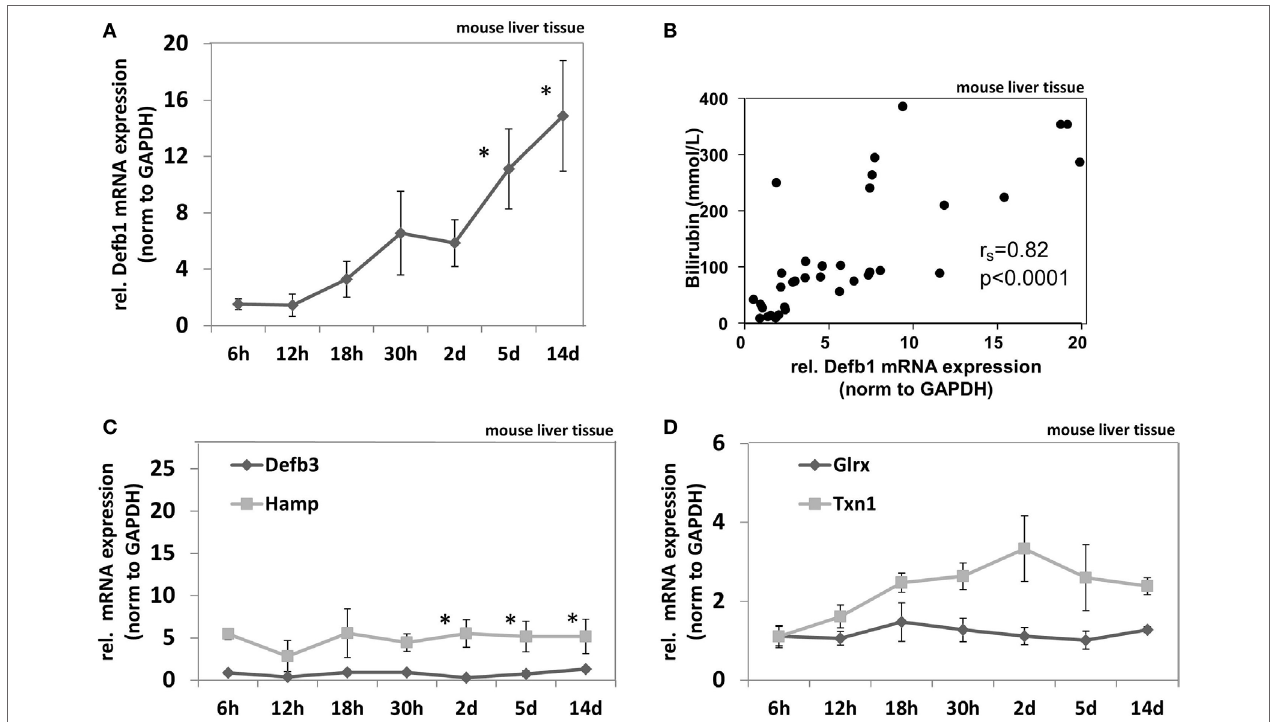
FigUre 4 | In vivo expression of murine antimicrobial peptides in liver homogenates of bile duct-ligated mice. Gene expression pattern of Defb1 (a) , Defb3 and Hamp (c) , as well as Glrx and Txn1 (D) at multiple time points after bile duct ligation. Gene expression levels are shown as fold changes to sham-operated mice (0 h), normalized to GAPDH levels as average of 5 mice per time point. Error bars indicate SDs. Data were analyzed by student’s t -test; * p < 0.01. (B) Correlation matrix between mRNA expression of Defb1 and bilirubin values. Spearman’s rank correlation coefficient is indicated as r s . Statistical significance for comparison was p <